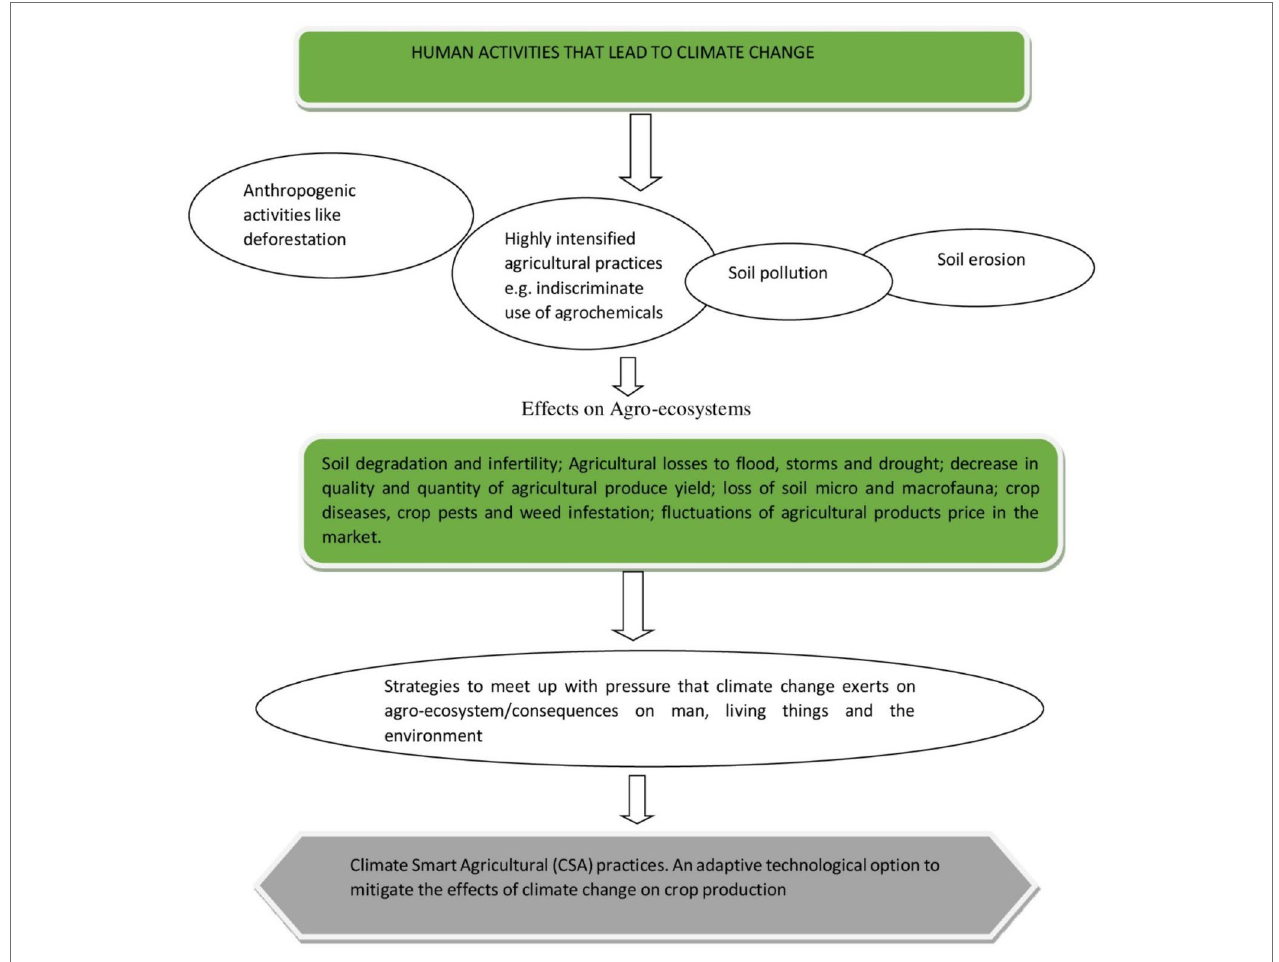
FIGURE 2 | Schematic highlighting of the different pressures exerted by climatic change and CSA as a mitigating practice to improve agricultural